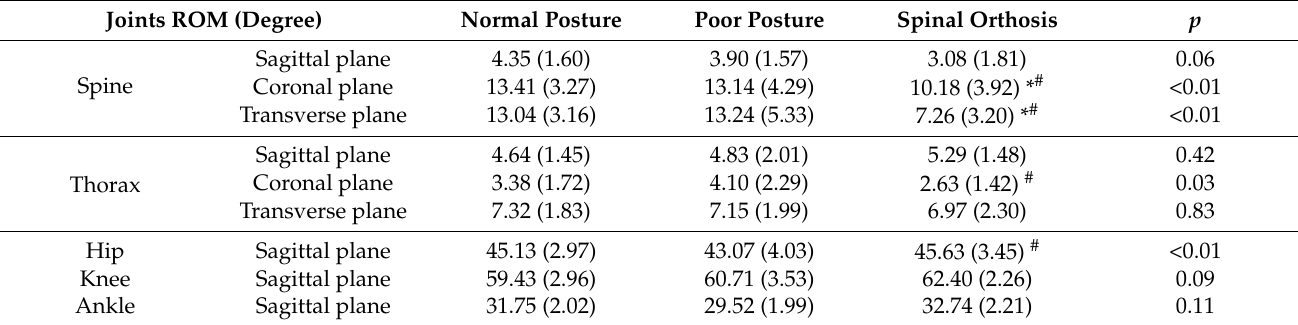
Table 1. ROM of the joints during the gait cycle (mean ±